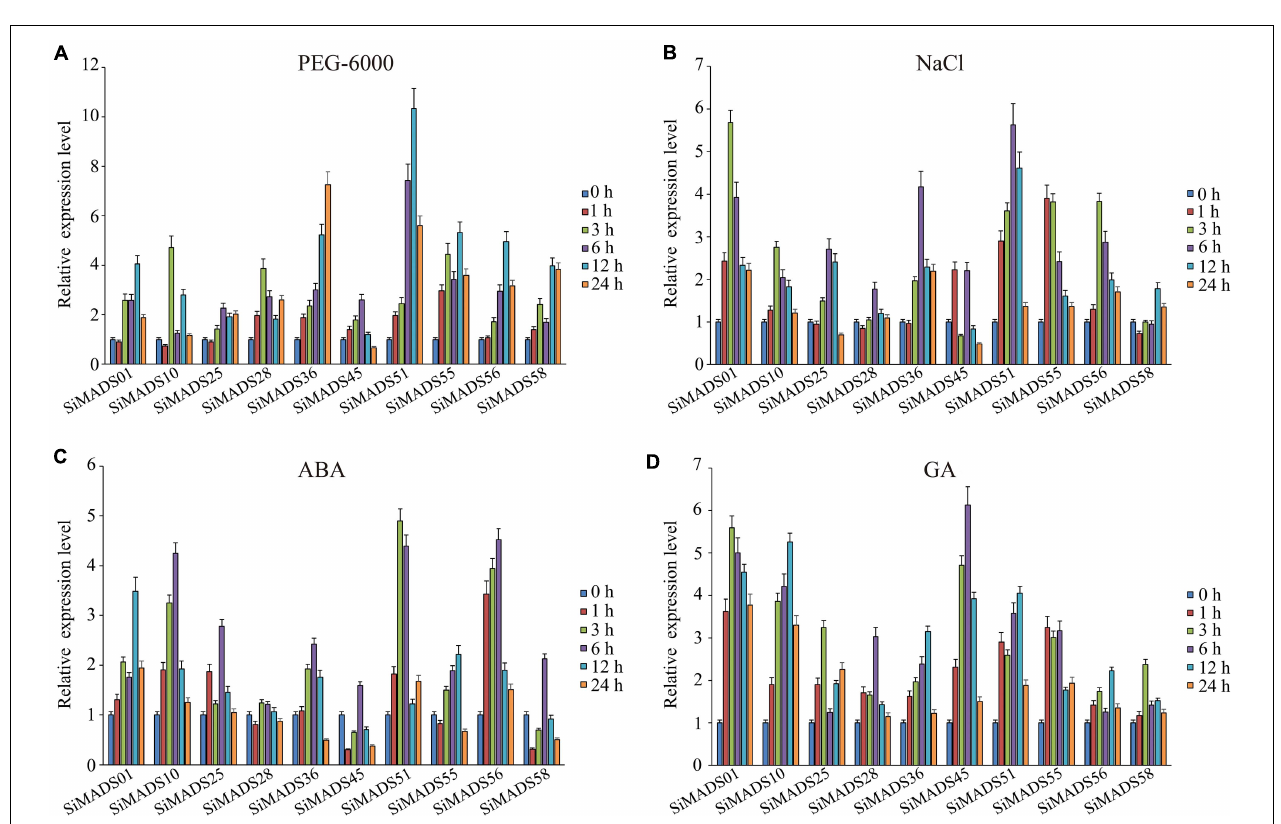
FIGURE 6 | Expression level of ten foxtail millet MADS-box genes under (A) PEG-6000, (B) NaCl, (C) ABA, and (D) GA treatment. The data were normalized to the foxtail millet actin gene (GenBank ID: AF288226). Three biological replicates were performed, and the values are presented as the means ± SD.